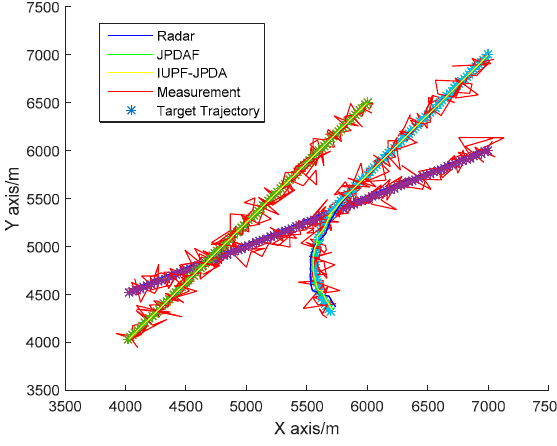
Figure 10. Multi-target simulation experiment prediction trajectories.